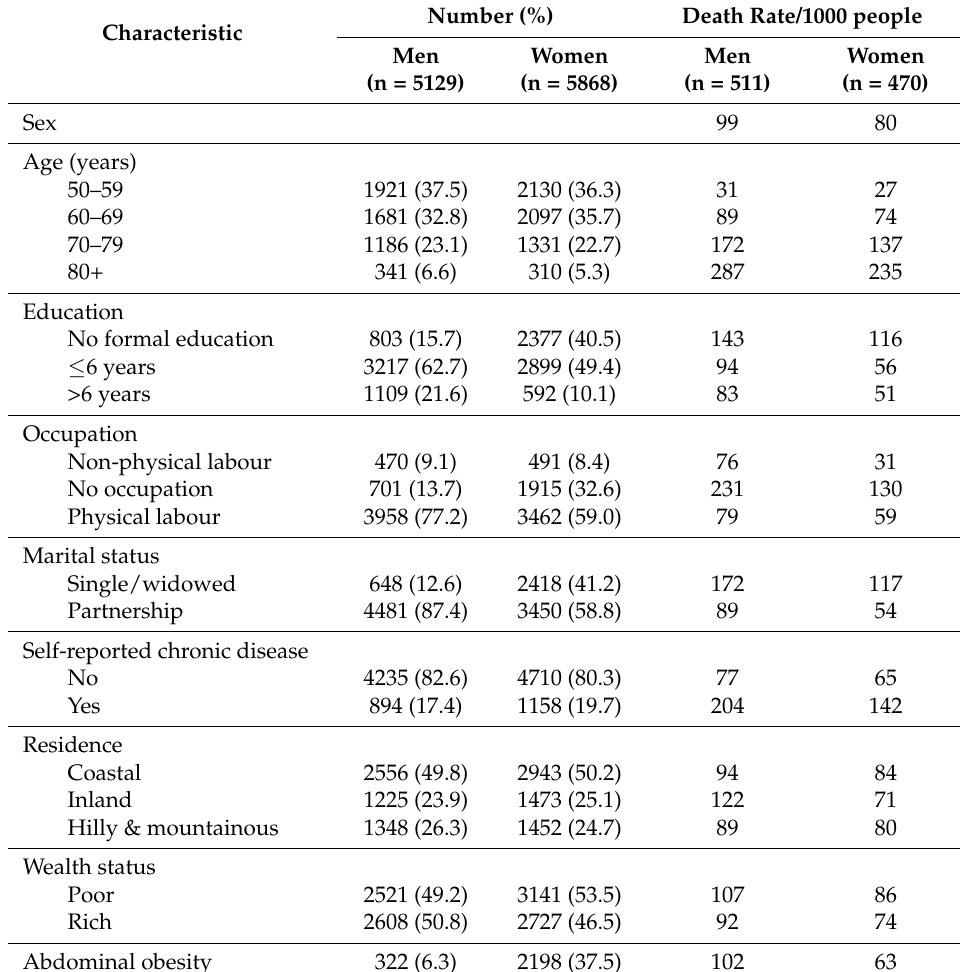
Table 1. Percentage (%) of men and women by socioeconomic characteristics and abdominal obesity at baseline in 2007 and death rate/1000 people during the study period 2007–2010 (n = 10,997). WHO-INDEPTH SAGE Purworejo longitudinal